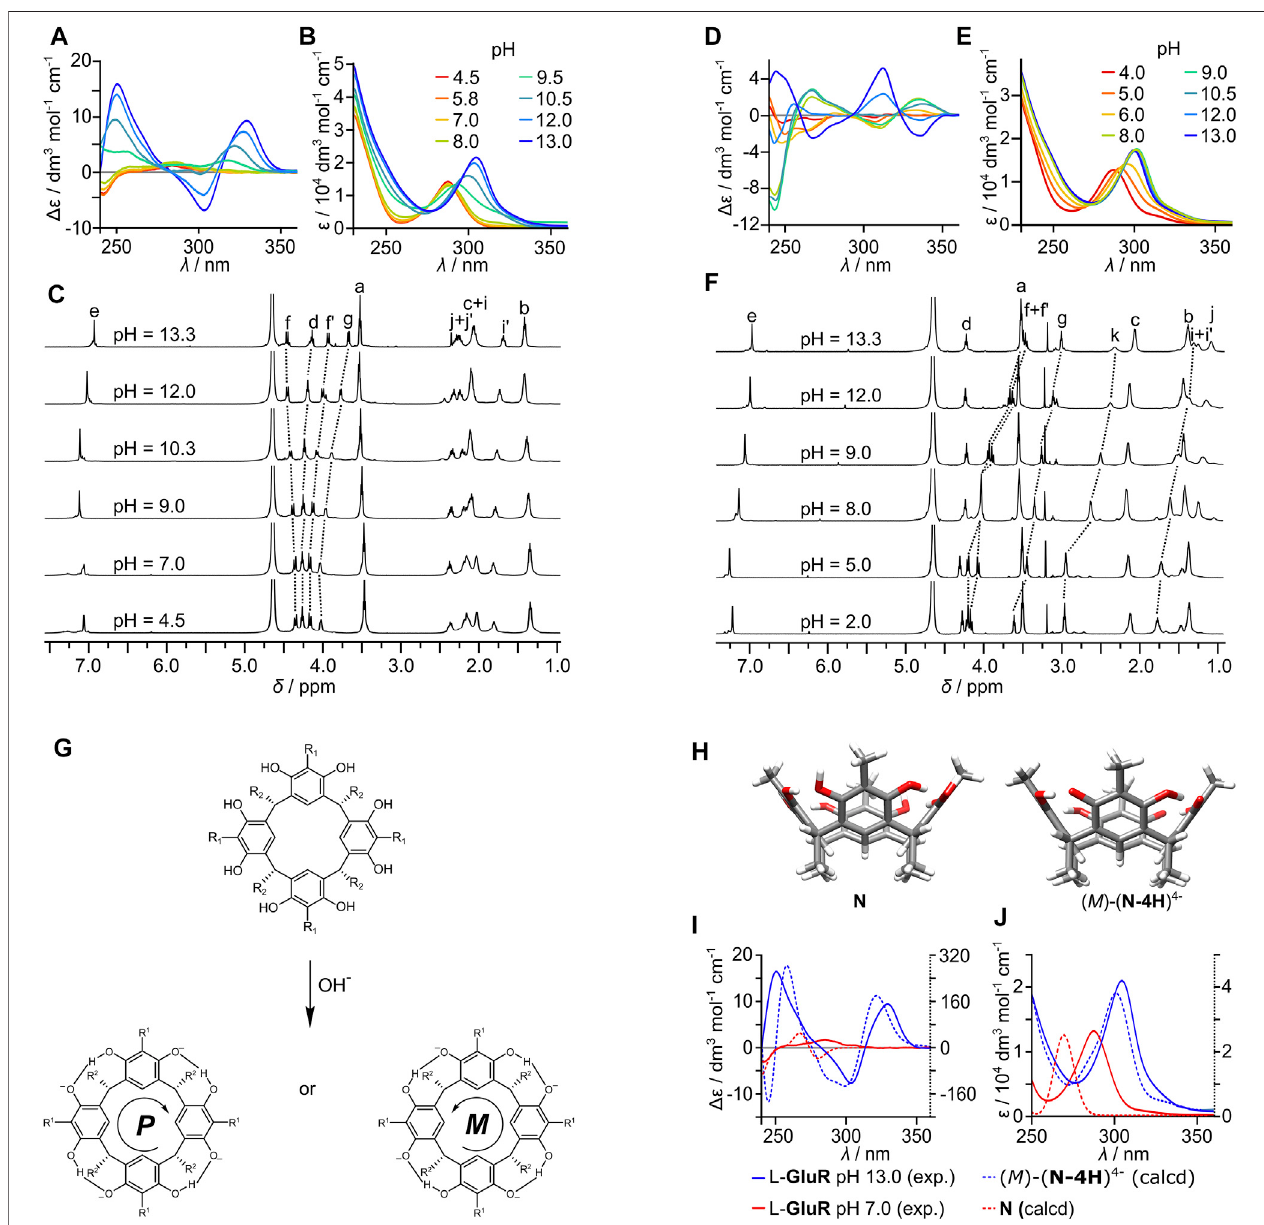
FIGURE 3 | Structural changes of homodimers upon pH change: (A,B) pH-dependent ECD and UV spectra of L- GluR (C = 3.1 mM, water, pH was adjusted by usingNaOH); (C) pH-dependentchangesofNMRspectraof(L- GluR ) 2 (C=10 mM,water,pHwasadjustedbyusingNaOD); (D,E) pH-dependentECDandUVspectra ofL- ArgR (C=3.1 mM,water,pHwasadjustedbyusingNaOH); (F) pH-dependent 1 HNMRspectraof(L- ArgR ) 2 (C=10 mM,water,pHwasadjustedbyusingNaOD); (G) postulated mechanism of diastereoselective deprotonation; (H) geometry-optimized structures of model compounds: neutral (N) in C 4 inherently chiral conformation and tetraanionic, ( M )-( N-4H ) 4 − ; comparison of calculated and experimental spectra: (I) CD; (J) UV (TD DFT wb97xd/6-31+G(d); y-axis: left, solid axis — experimental intensity; right, dashed axis — calculated intensity).